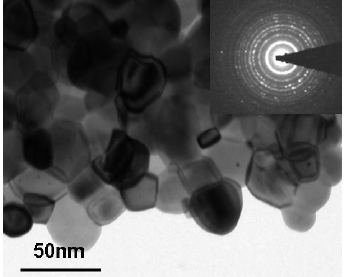
Figure 6a. TEM image of the as-prepared NiTiO nanoparticles calcined at 500 o C. 3